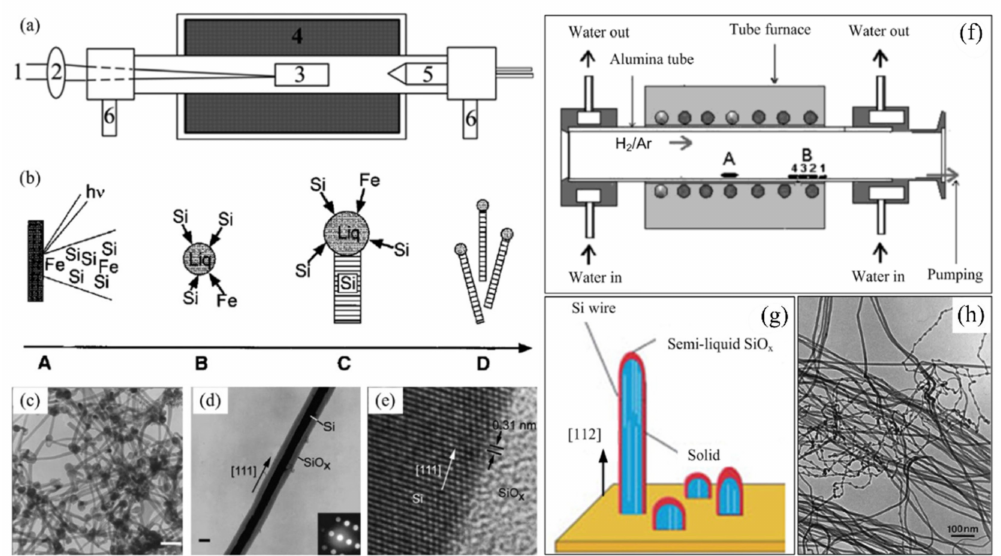
Figure 4. ( a ) Schematic diagram of the SiNW growth system. The output from a pulsed laser (1)